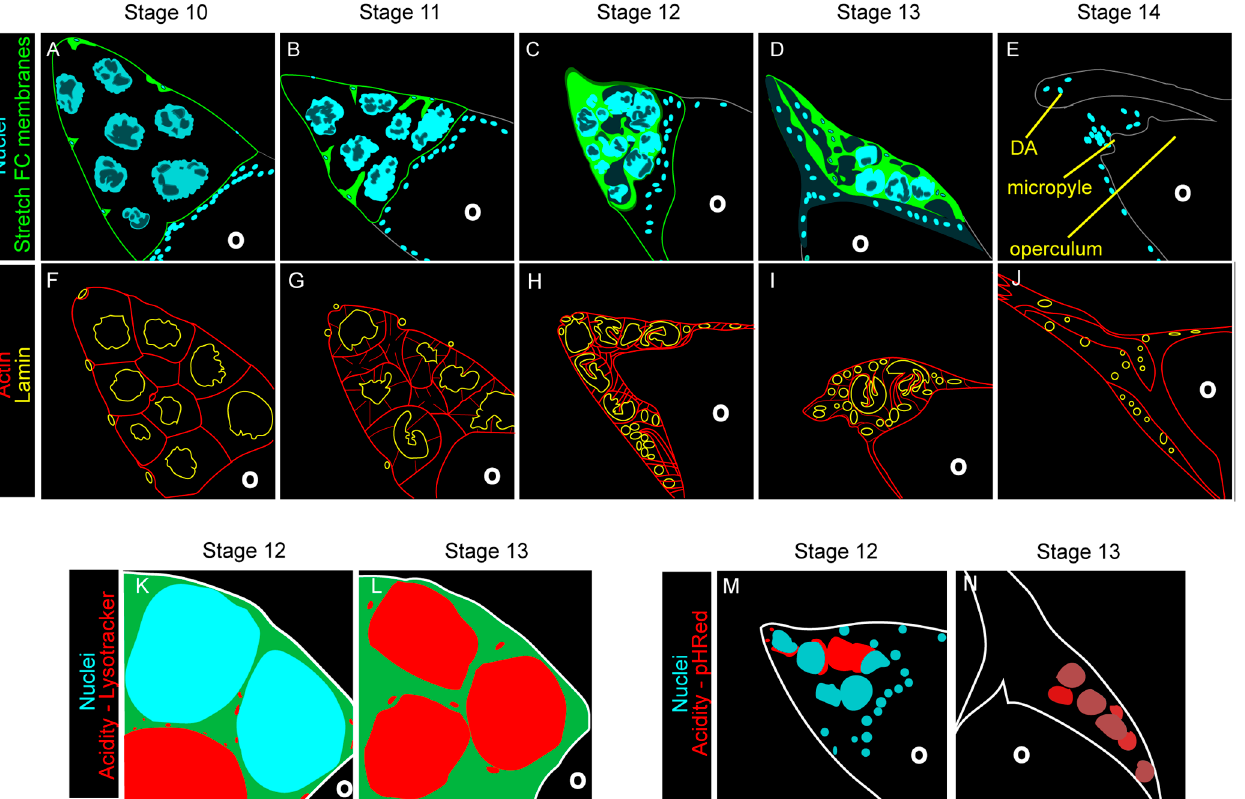
Figure 4. Developmental death of the nurse cells is orchestrated by the stretch follicle cells. ( A – E ) Images of the anterior portion of egg chambers during the late stages of oogenesis. (Adapted from [29]). ( A ) The anterior end of a stage 10 egg chamber with dispersed NC nuclei and surrounding FCs. ( B ) In a stage 11 egg chamber, NCs become smaller as they dump their cytoplasmic contents into the oocyte. Soon after, the stretch FCs invade the space between the NCs. ( C ) By stage 12, all of the cytoplasmic contents have been dumped into the oocyte and the stretch FCs have completely surrounded the NCs. ( D ) During stage 13, the NCs start to disappear and the dorsal appendages (DA) start to grow. ( E ) By stage 14, the NCs are completely eliminated, the DAs have fully extended, and the micropyle and operculum are complete. ( F – J ) Actin and lamin dynamics during developmental nurse cell death. (Adapted from [75]). ( F ) During stage 10, the only visible F-actin is cortical. The NC lamina, however, have already begun to fold creating crenellations (as compared to the smooth lamina of the stretch FCs). ( G – I ) During stages 11–13, actin bundles extend into the nucleus and the lamina undergoes additional folding, forming involutions and focal disruptions. ( J ) By stage 14, the only lamins present are those of the stretch FCs. The actin again can only be found subcortically. ( K , L ) NC nuclei become acidified during stages 12 and 13 (Adapted from [31]). ( K ) During stage 12, acidic organelles in the stretch FCs can be seen surrounding the NCs. ( L ) During stage 13, NCs become acidified. ( M , N ) NC acidity originates in the stretch FCs (Adapted from [31]). ( M ) During stage 12, acidity can be seen at the periphery of the nurse cells, near the stretch FCs. ( N ) During stage 13, acidity has flooded into the rest of the NC remnant. ( K – N ) The oocyte (O) is not affected by acidity.